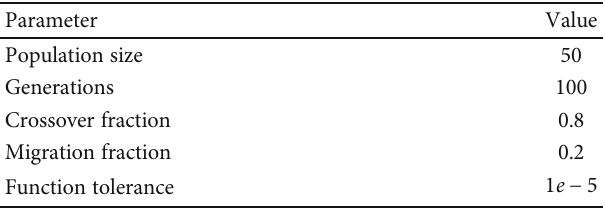
Table 3: Parameters of the genetic algorithm.